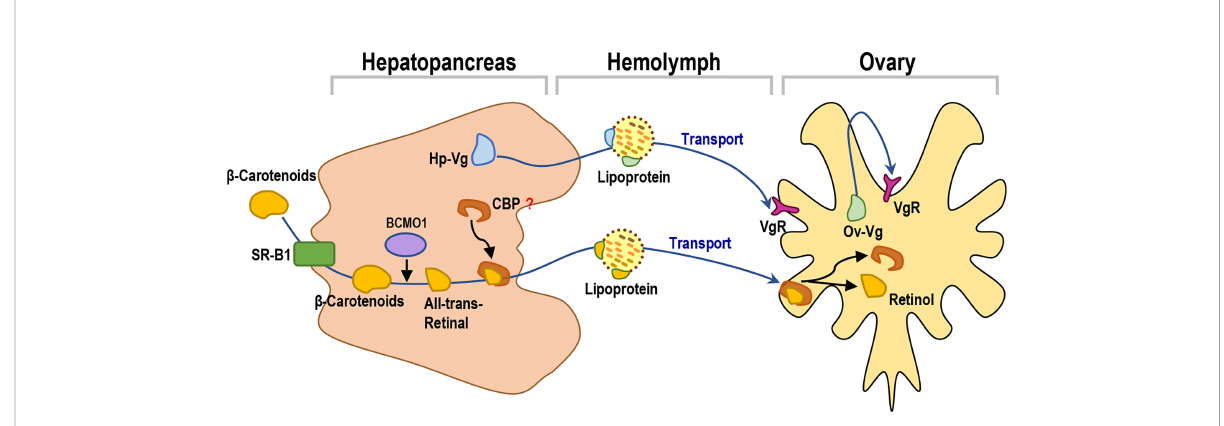
FIGURE 8 A working model for yolk nutrition production, transportation and accumulation pathways from the hepatopancreas to ovary in Paci fi c white